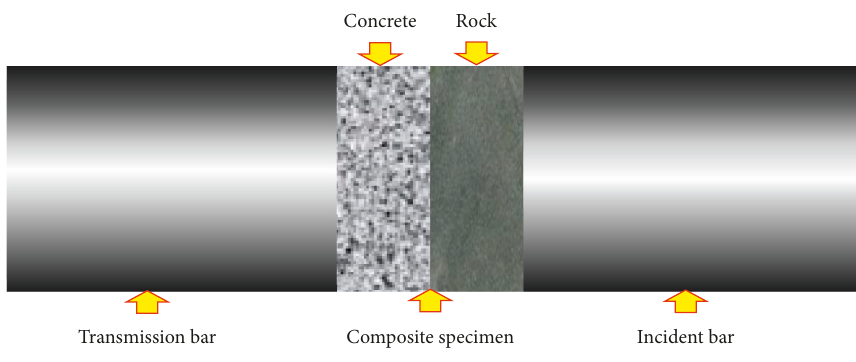
Figure 3: The clamping state of the specimen. Table 1: SHPB shock compression test results of concrete-rock combined bodies with different thickness ratios.